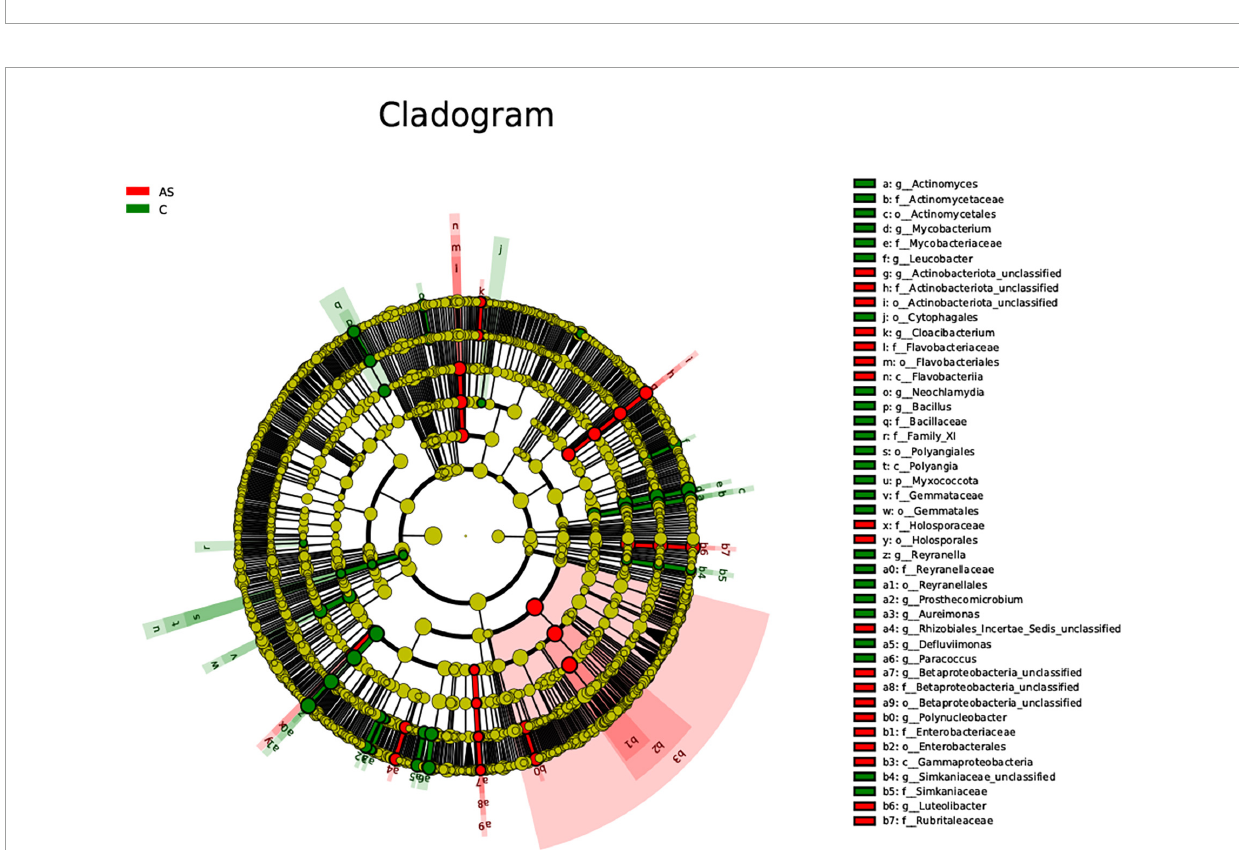
FIGURE7 All characteristic species were detected by LDA Effect Size (LEfSe) analysis using the Kruskal-Wallis rank sum test (calculated by Wilcoxon signed-rank test, Linear discriminant analysis (LDA) score > 3, and P < 0.05